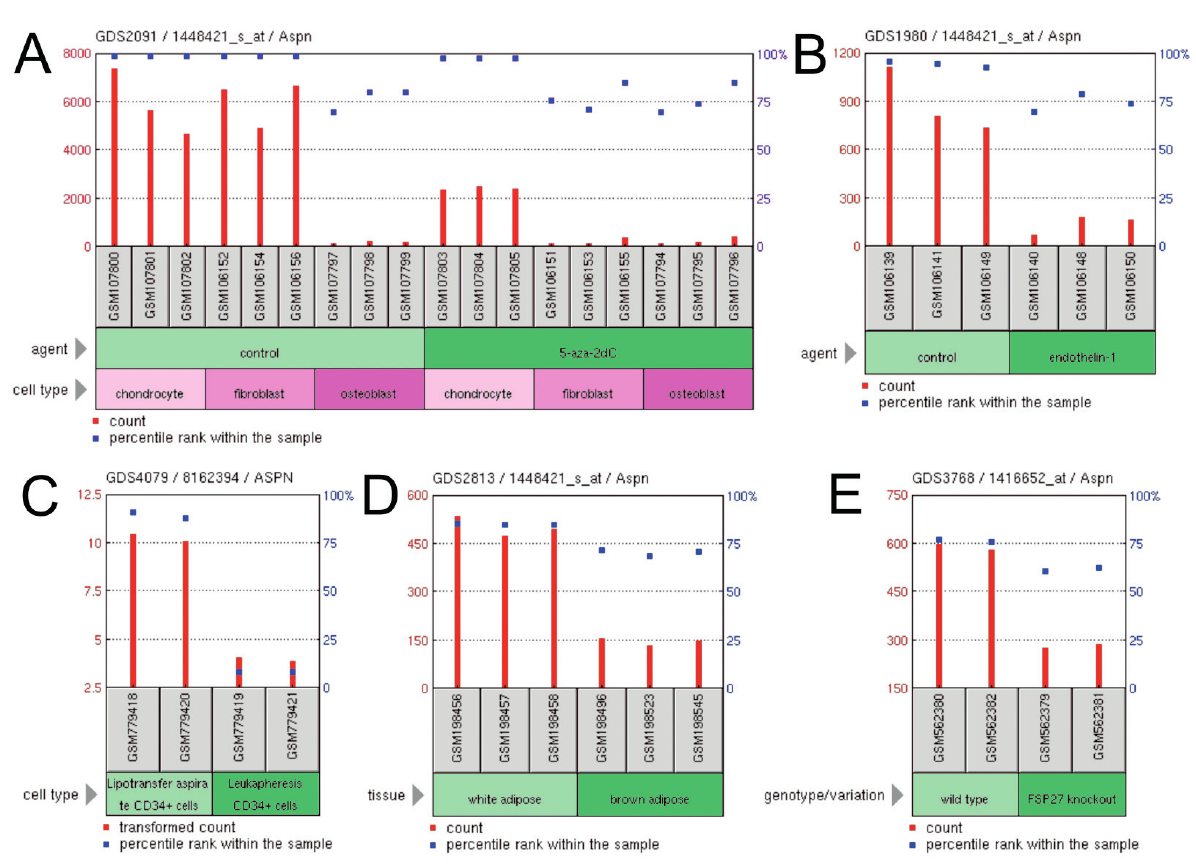
Fig. 1. A search of the Gene Expression Omnibus revealed modulation of asporin in specific conditions. ASPN was down- regulated by demethylation (A) or endothelin-1 (B) in a mouse model. Expression of ASPN was higher in human CD34+ cells from white adipose tissue obtained by lipotransfer than in those cells obtained from bone marrow by leukapheresis (C). ASPN expression was lower in brown adipose tissue (D) or upon FSP27 knock-out in white adipose tissue (E). Please refer to the main text for further